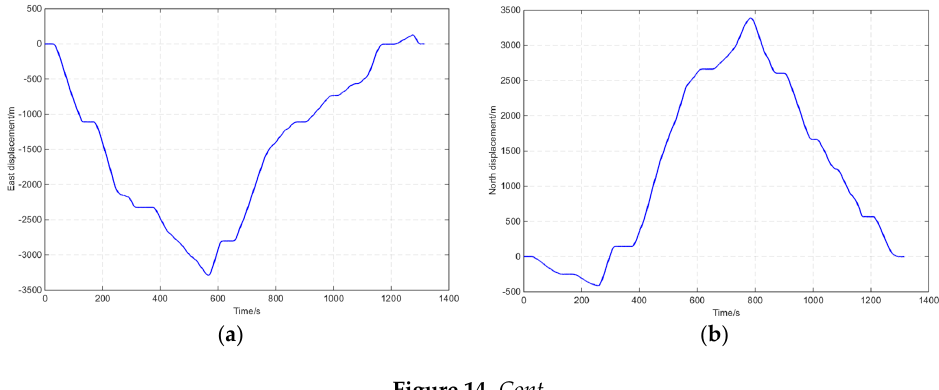
Figure 14. Cont. Figure 14.